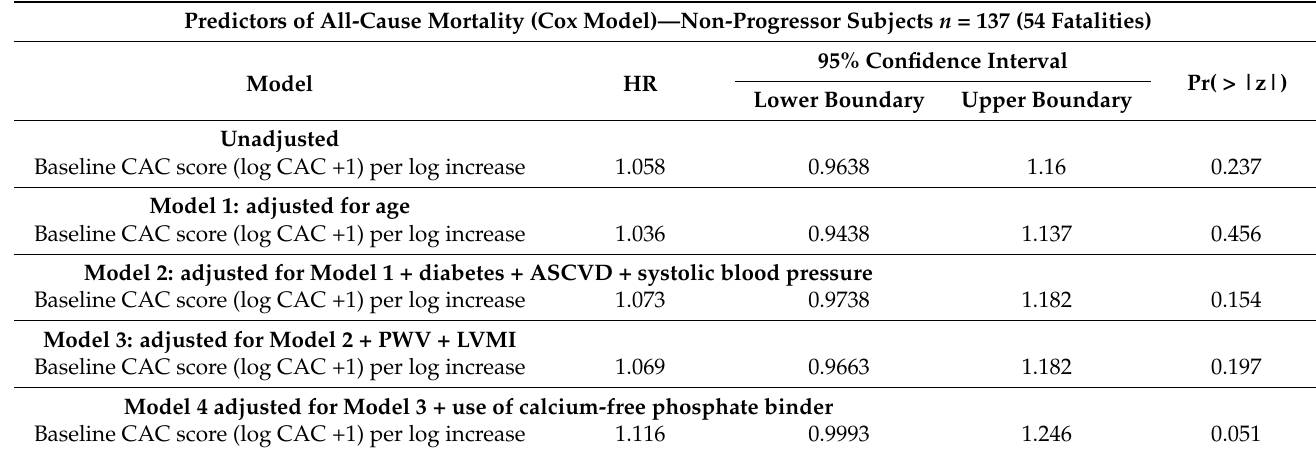
Table 6. Predictors of all-cause mortality among individuals with evidence of CAC